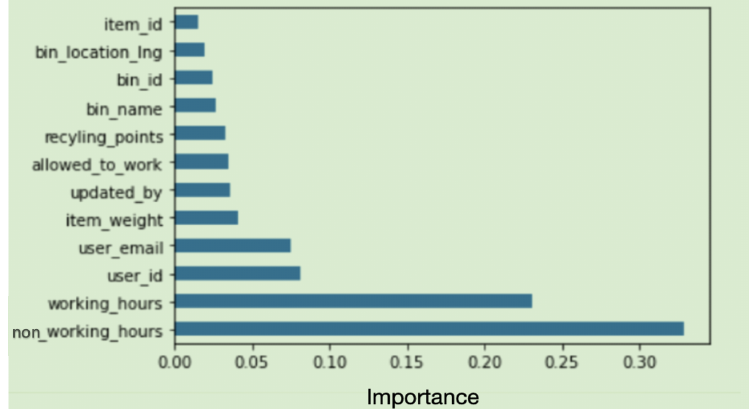
Figure 3. Most important attributes to the target variable status.